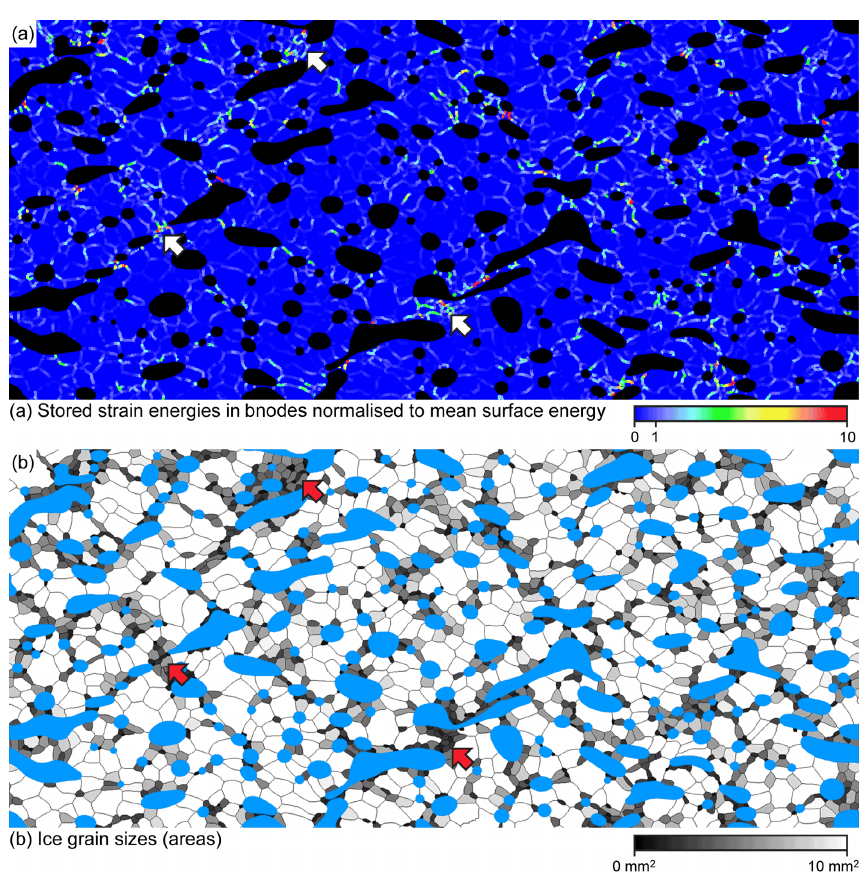
Figure 5. Details of results of simulation F20 at 53% vertical shortening. (a) Boundary nodes colour-coded according to the proportion of strain-induced boundary migration. Air inclusions are plotted in black since they do not contribute to strain-induced boundary migration. (b) Microstructure colour-coded according to the areas of ice grains, with air inclusions displayed in blue. Smallest grains appear grey to black. Arrows in both images indicate zones of marked strain